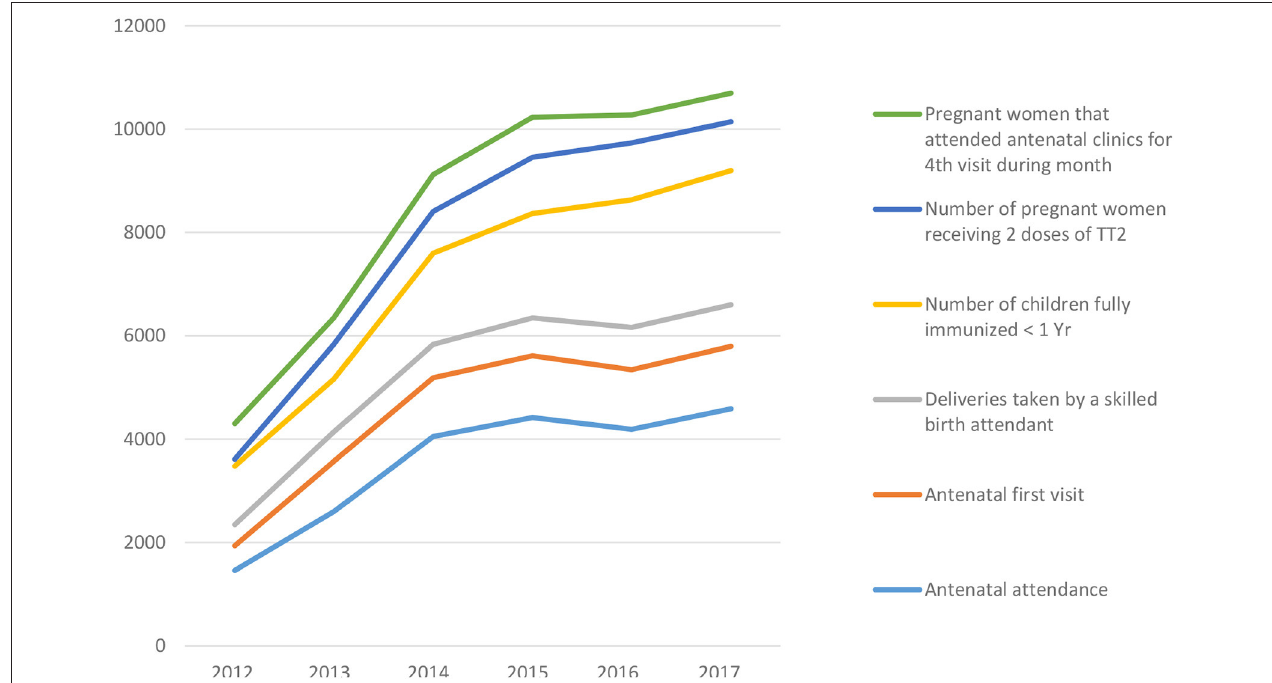
FIGURE 2 | Trend of MCH service uptake pre, during and post-SURE P/MCH intervention among pregnant women between 2012 and 2017 in Anambra state,